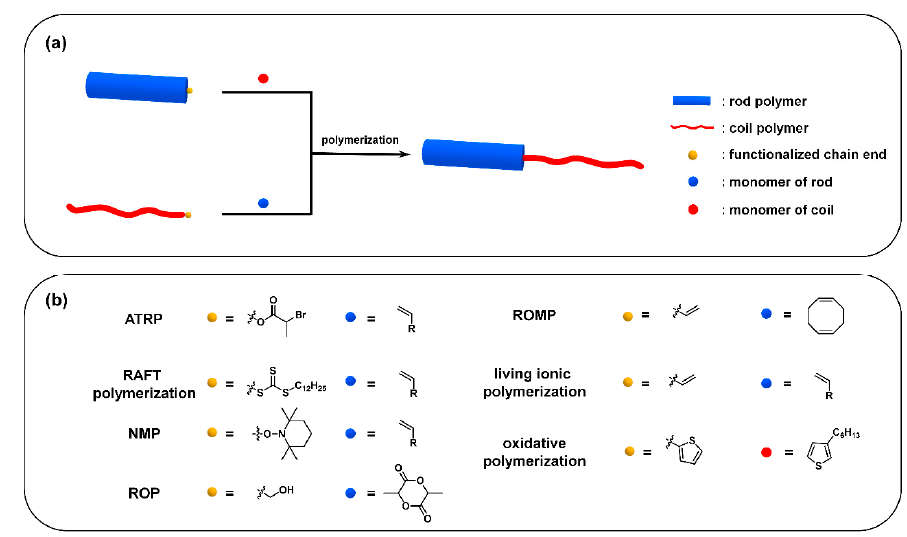
Figure 5. ( a ) The grafting-from approach from rod polymer and roil polymer; ( b ) representative functionalized chain end and monomer for different polymerizations.